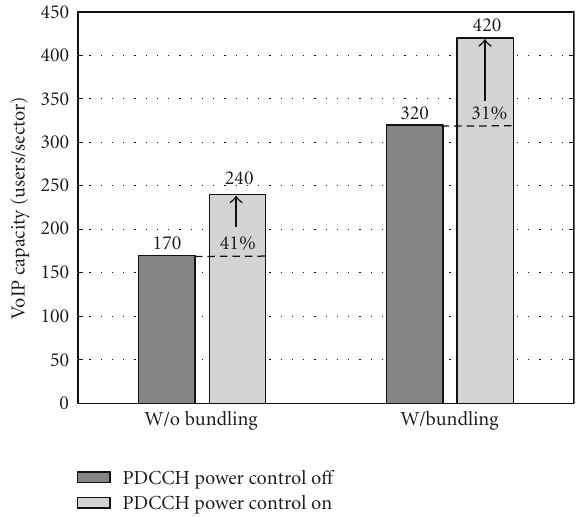
Figure 4: VoIP capacity comparison between without PDCCH power control and with PDCCH power control in 5MHz system bandwidth (Macro Case 1).